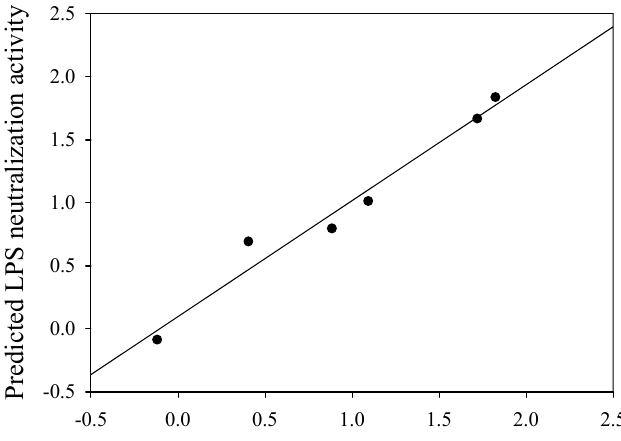
Figure 6. Plot of predicted versus experimental ED 50 for the leave-one-out cross-validation testing set of